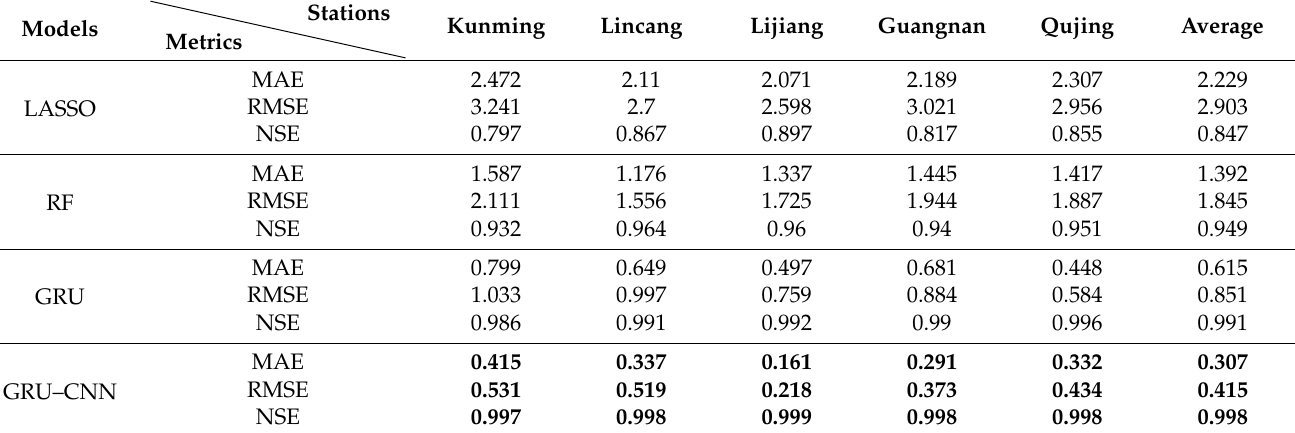
Table 7. Performance of MCI drought index prediction models computed in the 3rd month in the